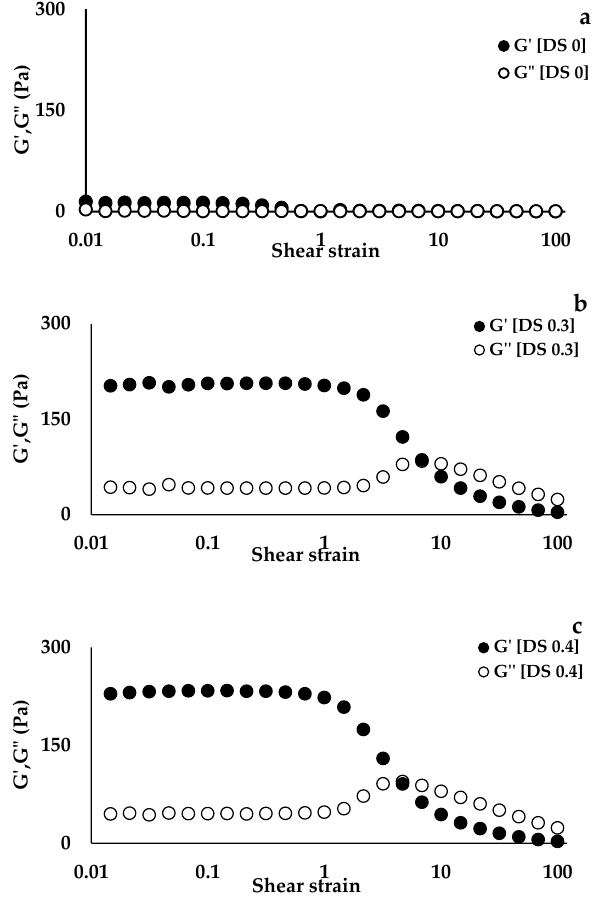
Figure 6. Different storage modulus and loss modulus with shear strain change from different DS − treated green waste biomass. ( a ): DS 0, ( b ): DS 0.3, ( c ): DS 0.4.